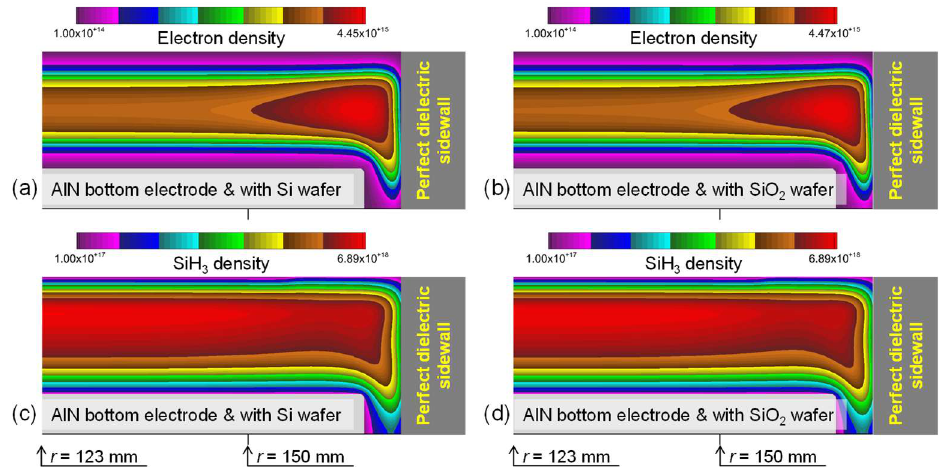
Figure 6. Effects of the dielectric constant of the wafer on the spatial distribution of the plasma parameters. Contour plots for the spatial profiles of the time-averaged electron density (m −3 ) for ( a ) Case 6 and ( b ) Case 7 for r ≥ 123 mm. Contour plots for the spatial profiles of the time-averaged SiH 3 density (m −3 ) ( c ) for Case 6 and ( d ) for Case 7 for r ≥ 123 mm. The profiles are radially uniform for r < 123 mm.